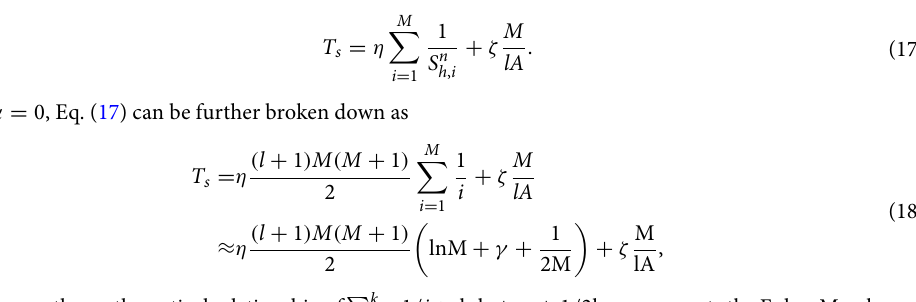
In Fig. 6c, the solid red line with the star symbol and the solid blue line with the circle symbol, respectively, indicate the measurements of uniform preferences and weighted preferences with α resent the fitting lines obtained using Eq. (17) and Eq. (18). We confirmed that our model describes the